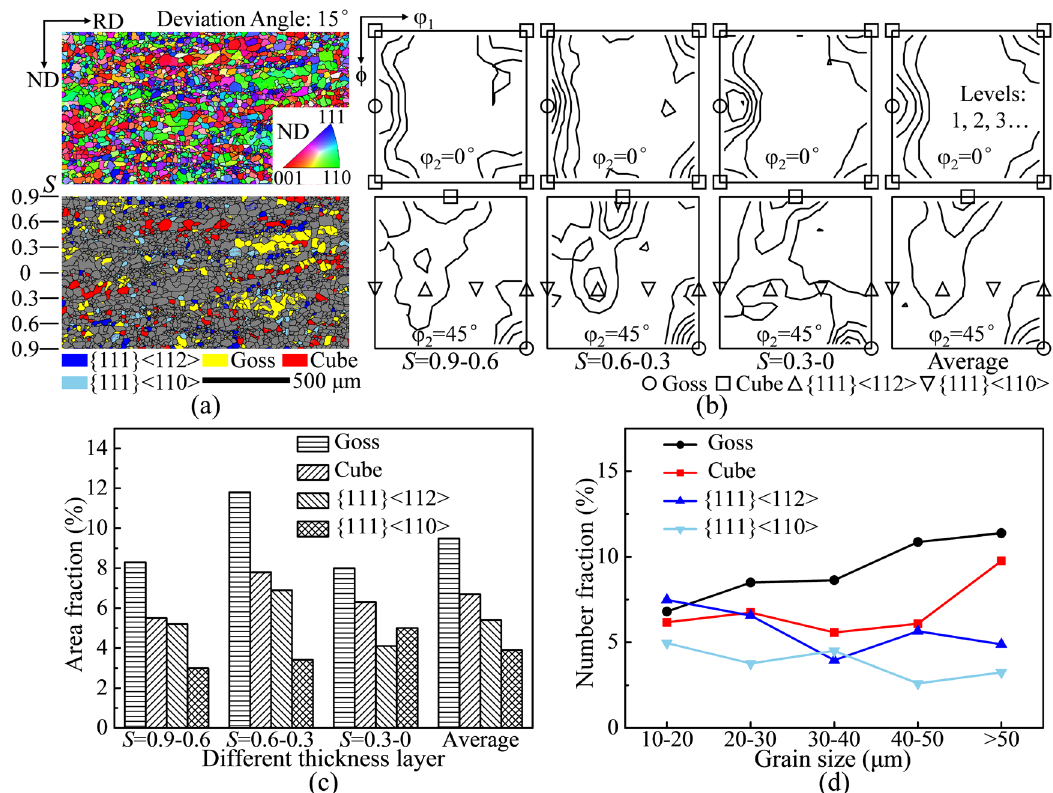
Figure 5. Micro-texture of just completely recrystallized Fe-2.1 wt.% Si sheets after annealing at 750 °C for 3 min: (a) Orientation image maps; (b) constant φ = 0° and 45° sections of ODFs and (c) area fractions of main texture components within different thickness 2 layers; and (d) number fraction distribution of main texture components in different size